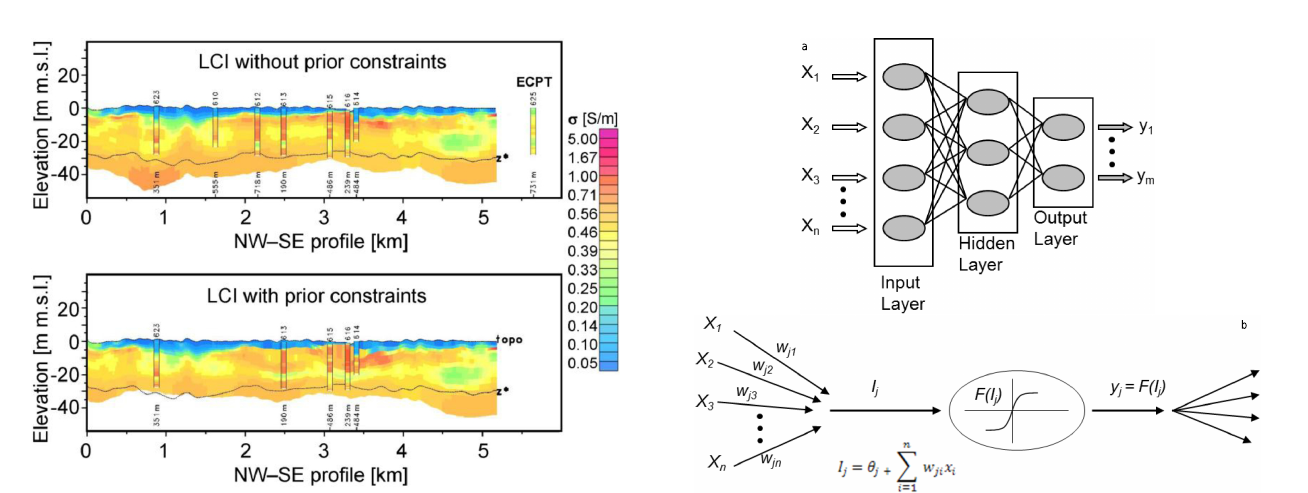
Fig. 12. (a) Typical layout of Artificial Neural Network (ANN) ar- chitecture. (b) Activation of transfer function in